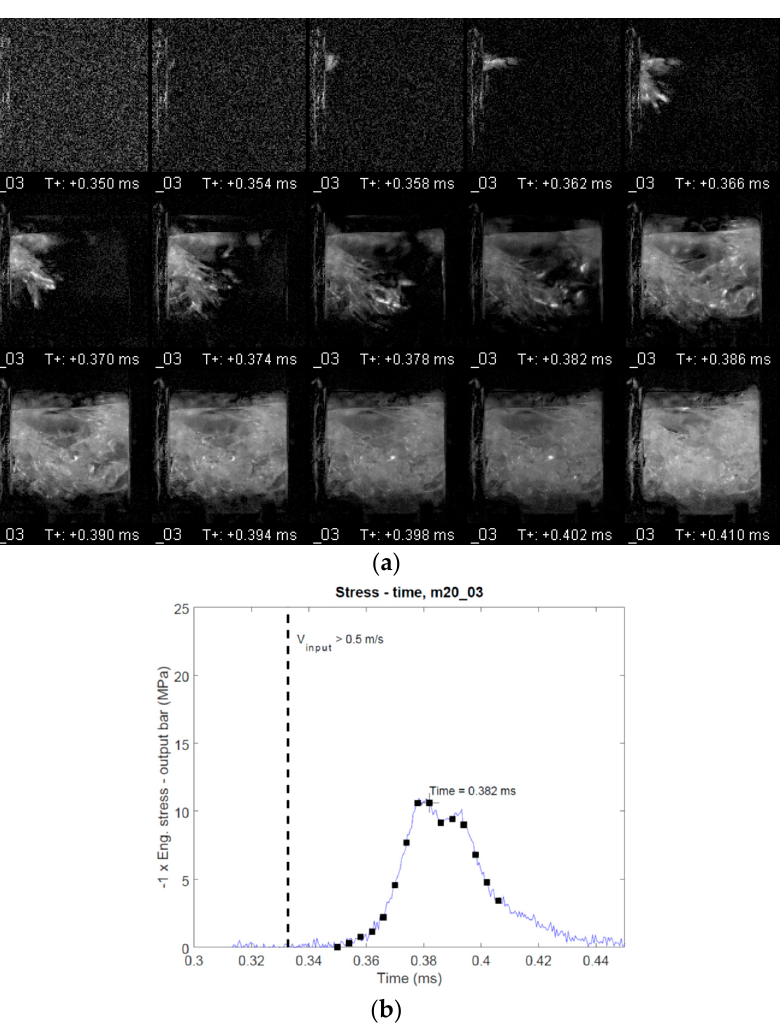
Figure A2. ( a ) Processed high speed footage obtained in the high rate test m20_03, ( b ) corresponding specimen stress-time signal obtained from the output bar strain gauge measurement (synchronized with high speed footage). The input bar is located on the left-hand side of the figure in ( a ). The time, at which the input bar end velocity exceeded 0.5 m/s as well as the times corresponding to the high speed frames are marked on the respective stress-time curve.